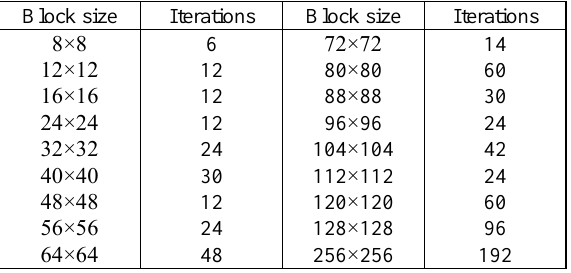
Table 1. The number of iterations for different block sizes, after which original block will be obtained.